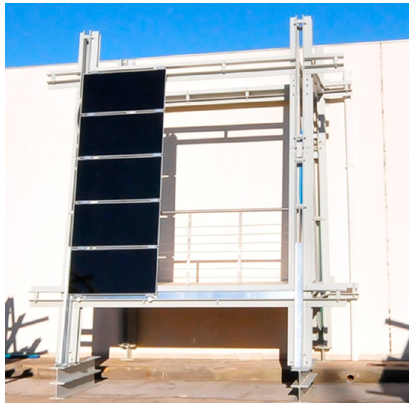
Figure 1. The grid prototype of the dissipative frame.